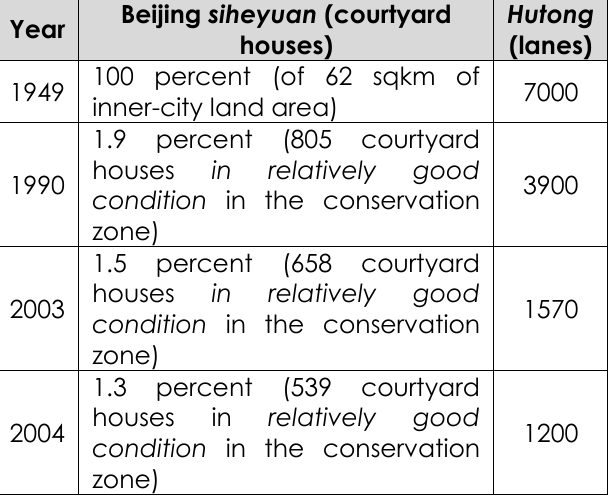
Table 1. Destruction and conservation of Beijing Siheyuan and